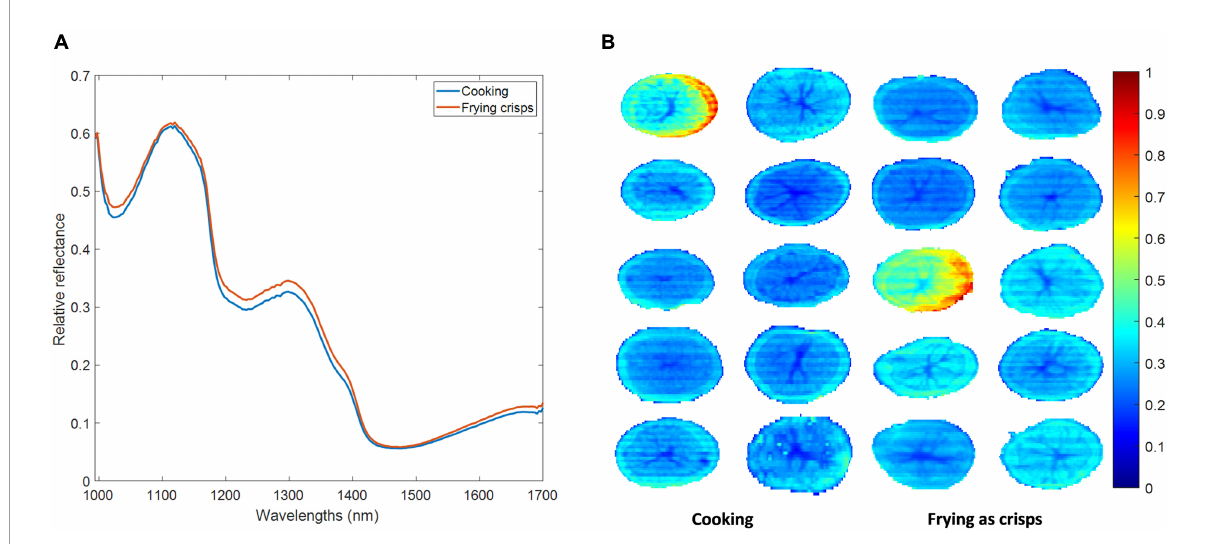
FIGURE2 Mean reflectance spectra of all tubers belonging to cooking and frying as crisps classes (A) and reflectance intensity values of all pixels at 1,210 nm of cooking and frying as crisps classes included in the calibration dataset in the pixel-wise classification approach (B)